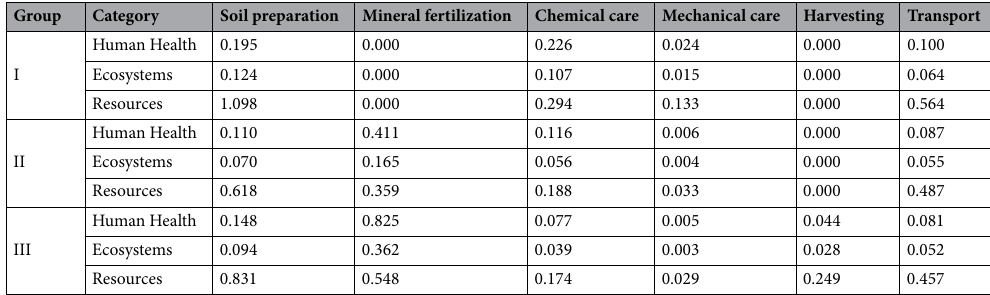
Group Category Soil preparation Mineral fertilization Chemical care Mechanical care Harvesting